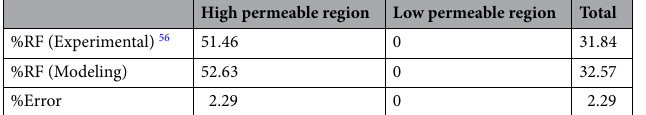
Table 3. Comparison of modeling and experimental results for water flooding test.